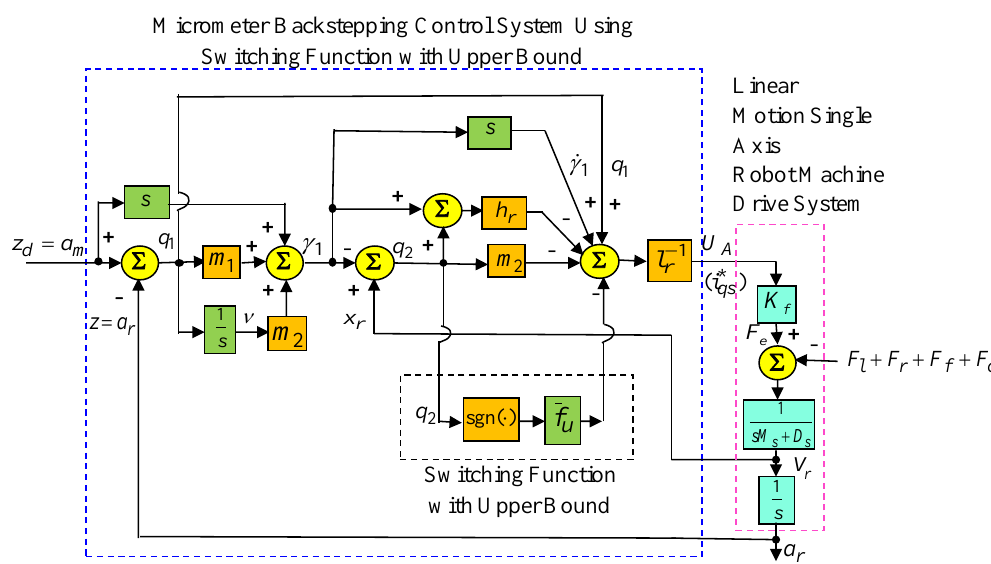
Figure 6. Micrometer backstepping control system using switching function with upper bound.